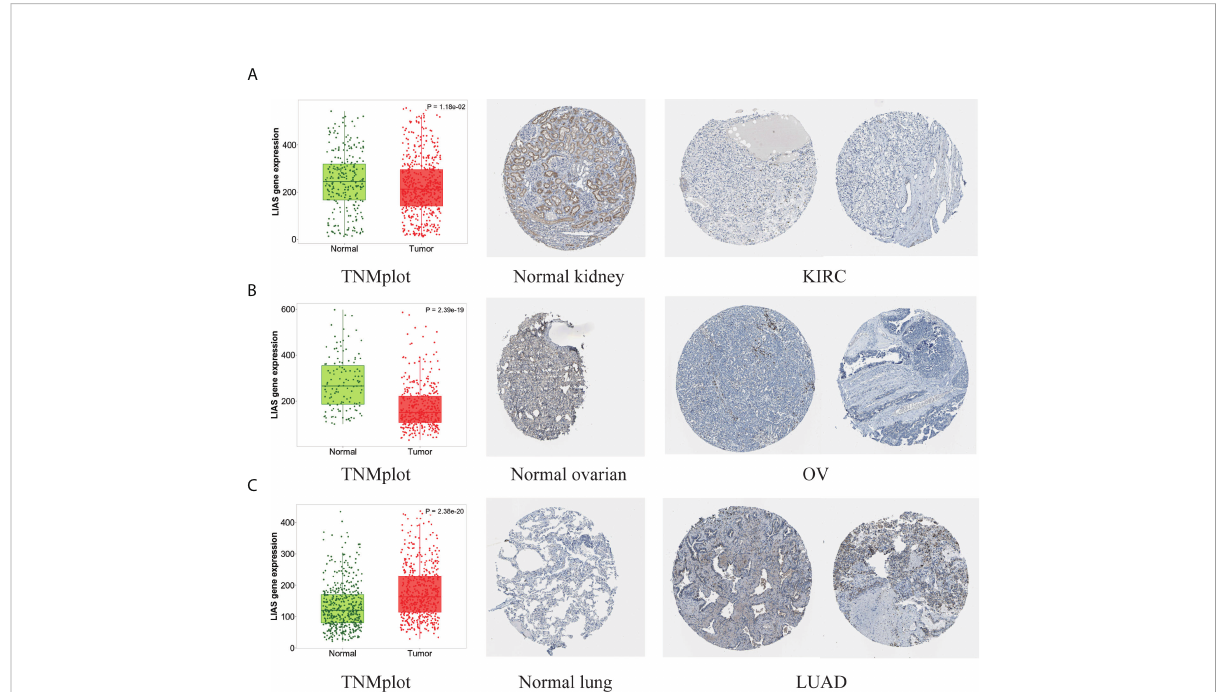
FIGURE 2 The different expression levels of LIAS in tumor and normal tissues. (A – C) TNMplot and HPA platforms displayed the downregulated expression of LIAS in KIRC and OV, and the upregulated expression in LUAD.